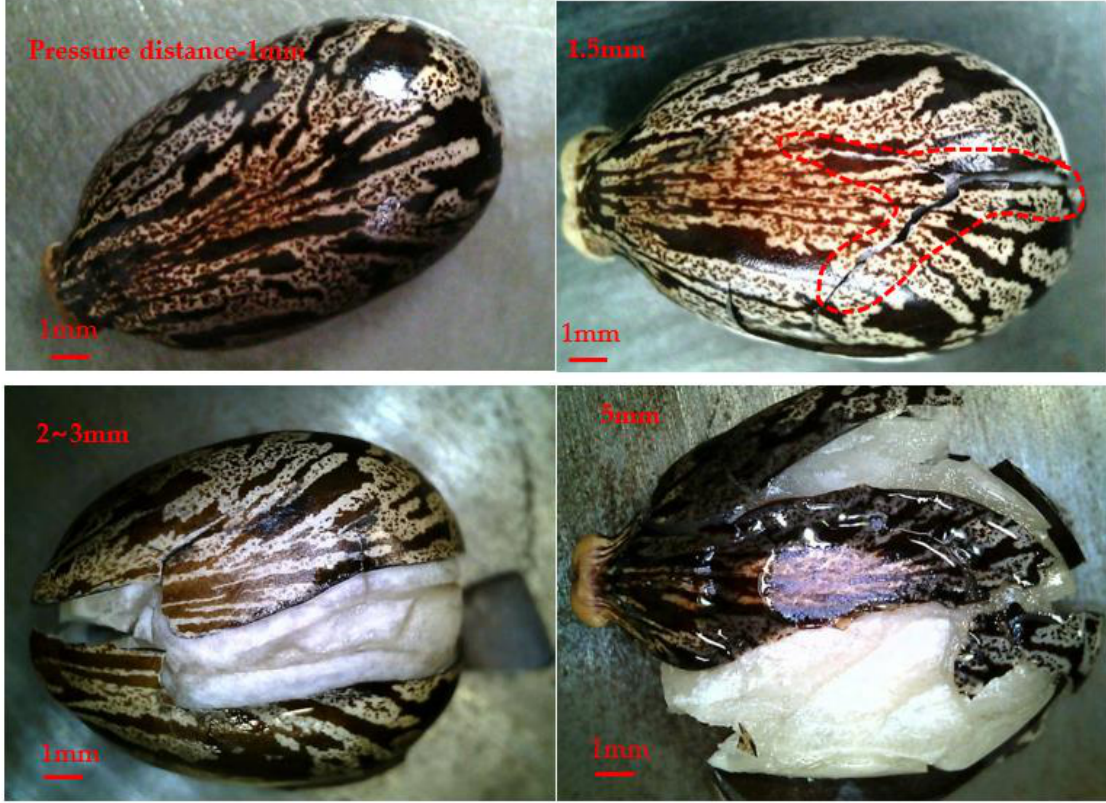
Figure 4. Observation image of cracks in castor bean outer seed coat.